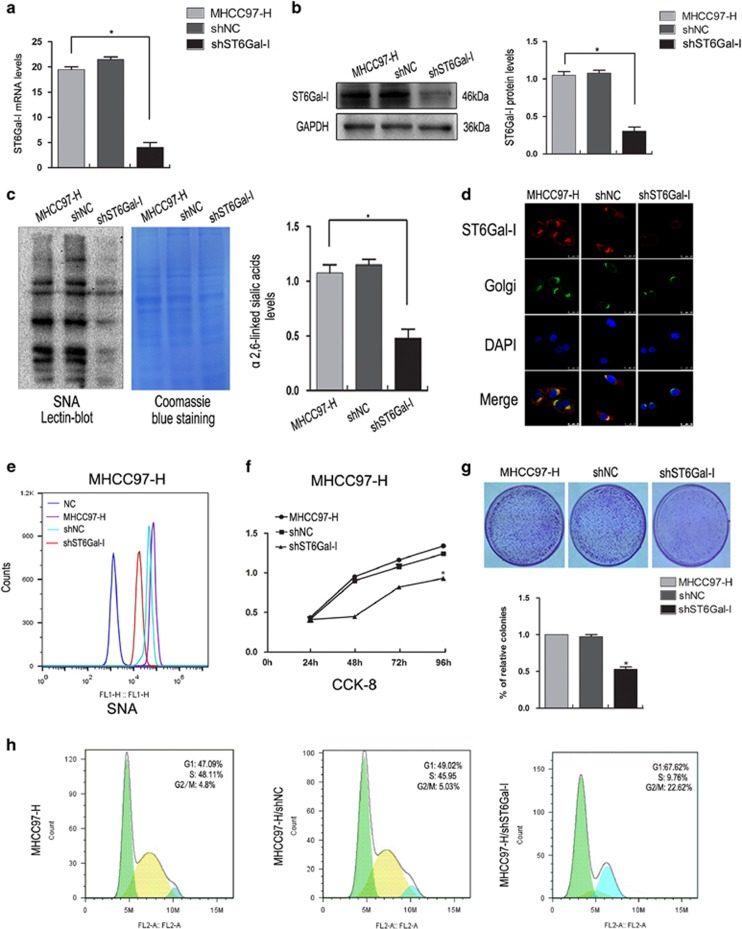
Depletion of ST6Gal-I in MHCC97-H cell line inhibits cell growth and metastasis in vitro. (a, b, d) Analysis of ST6Gal-I expression in MHCC97-H cells transfected with shST6Gal-I by qPCR (a), western blotting (b) and immunofluorescence (d), original magnification was × 40. (c, e) Knockdown of the expression of ST6Gal-I could affect α2, 6-linked sialic acid expression levels as determined by lectin blotting and flow cytometry assay. (f) Cell Counting Kit (CCK-8) assays showed that knockdown of ST6Gal-I expression leads to inhibition of cell proliferation. (g) Colony formation numbers was lower in ST6Gal-I-low expression cells (MHCC97-H/shST6Gal-I group) than in controls. (h) Flow cytometry assay showed that ST6Gal-I depletion leads to G1 arrest. (i) Cell migration ability as analyzed by wound healing assay in MHCC97-H cells following ST6Gal-I silencing at different time points. (j, k) Transwell assays were used to analyze the invasion and migration abilities of MHCC97-H transfected with shST6Gal-I. *P<0.05.